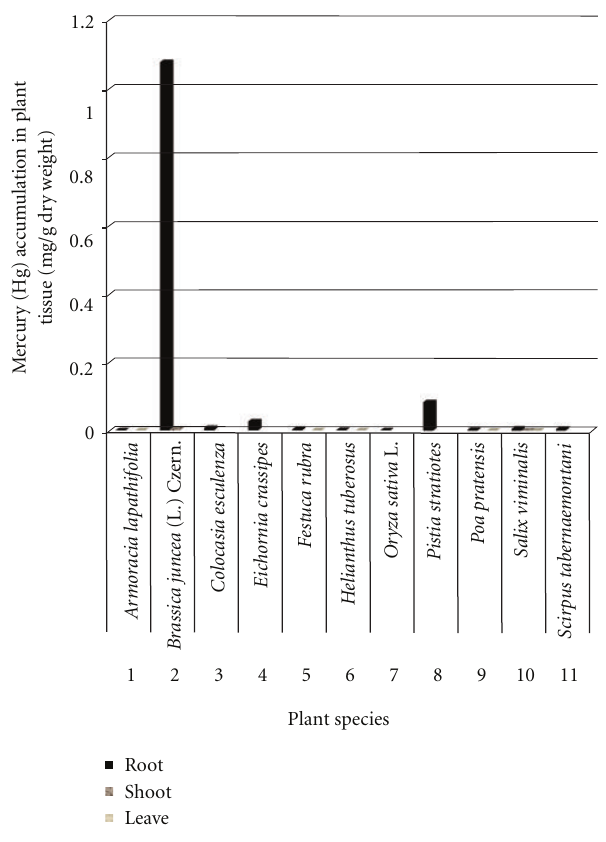
Figure 6: Hg accumulation in plant